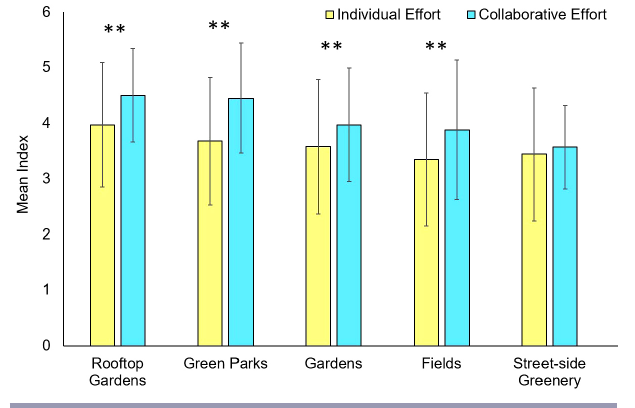
Fig. 6 . Individual and collaborative effort for managing cultural ecosystem services. Criteria of assessment for mean index: 1 = Not important, 2 = Slightly important, 3 = Moderately important, 4 = Important, 5 = Very important. Error bars represent standard deviation. * shows significant difference at < 0.001 based on paired sample